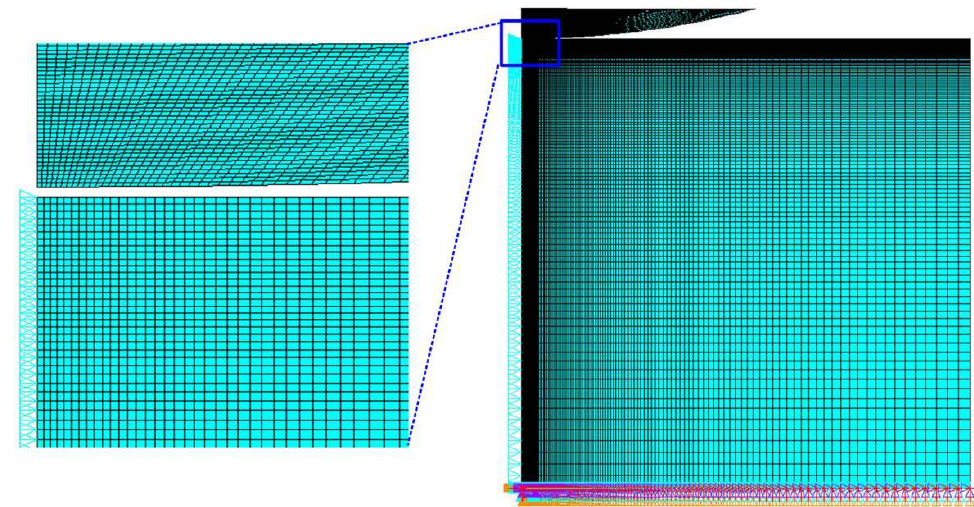
Figure 4. Axisymmetric finite element mesh model.